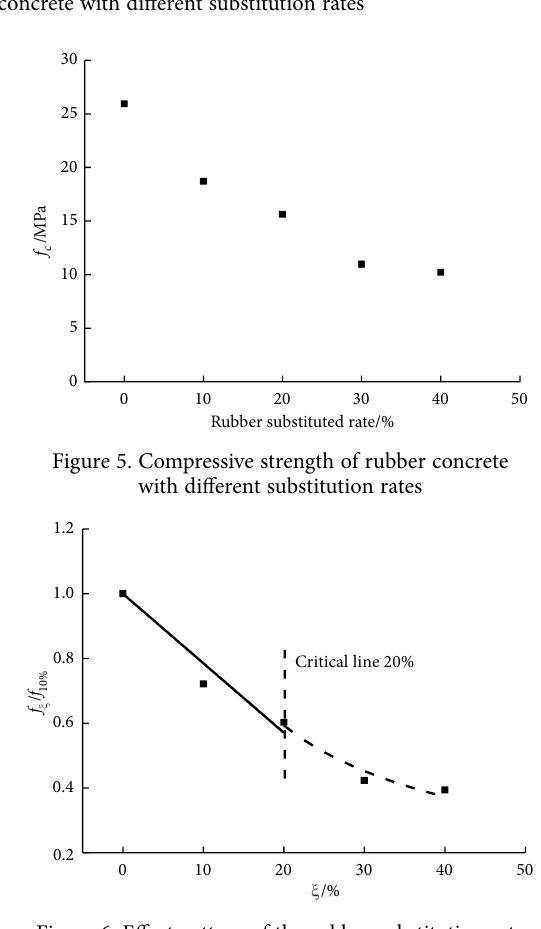
Figure 6. Effect pattern of the rubber substitution rate on concrete